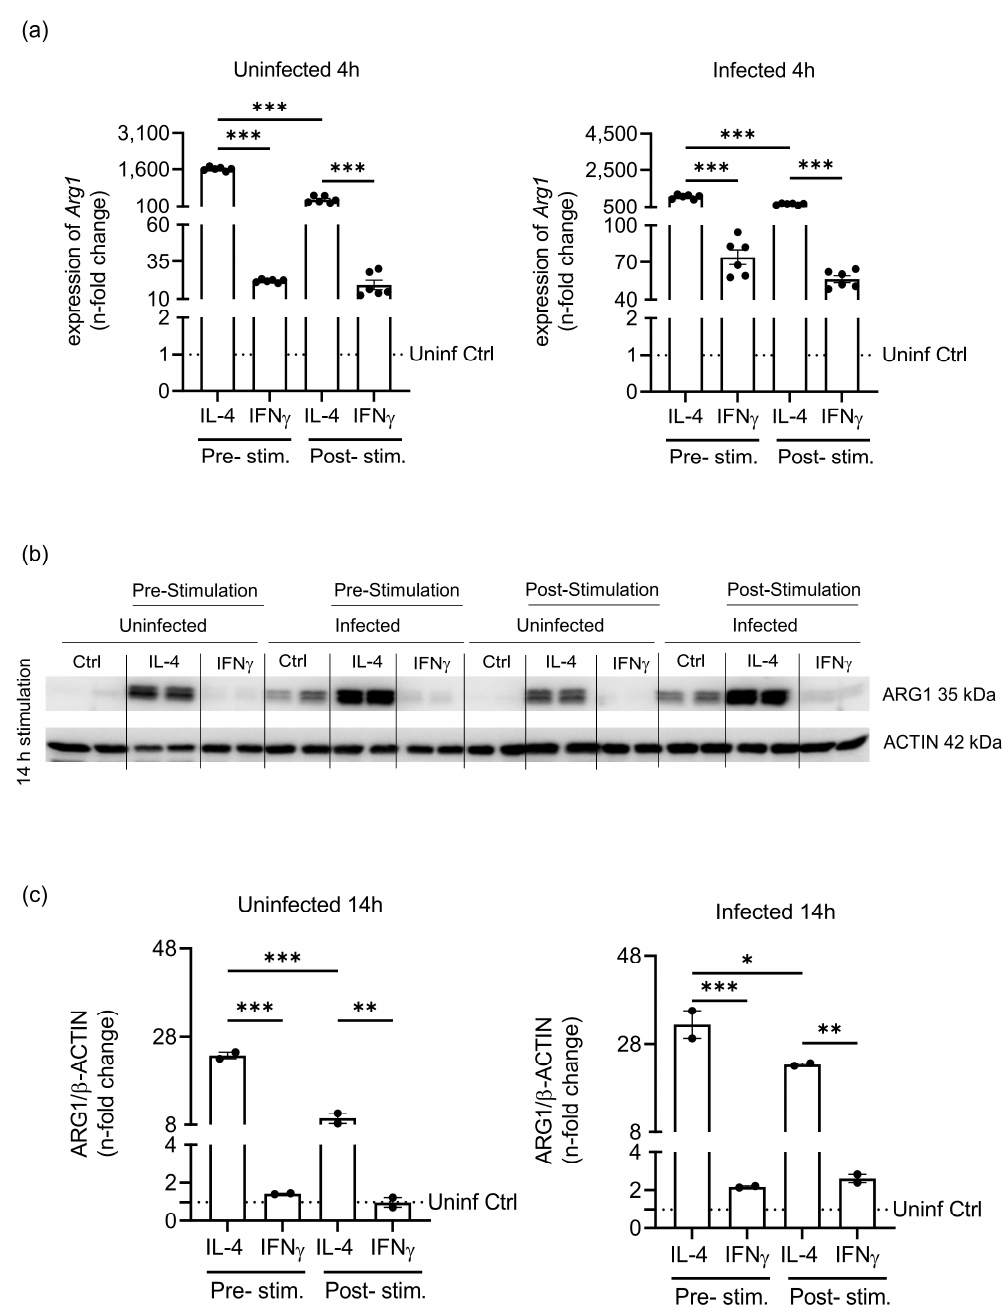
Figure 3. Priming of macrophages before S .tm infection shows differences in ARG1 regulation. Unpolarised BMDM and pre-stimulated polarised BMDM (2 ng/mL IL-4 or 20 ng/mL IFN γ ) were infected with S .tm for 1 h. Unpolarised cells were then stimulated (post-stimulation) with 10 ng/mL IL-4, 100 ng/mL IFN γ or left unstimulated for 4 h or 14 h. ARG1 mRNA and protein levels in pre- and post-stimulation conditions were analysed in uninfected and infected macrophages. ( a ) Arg1 gene expression depending on stimulation (IL-4 or IFN γ ) and infection. Arg1 transcript levels were determined by quantitative real-time PCR and normalized to Hypoxanthine phosphoribosyltransferase ( Hprt ) mRNA levels using the ∆∆ CT method. ( b ) Western blot analysis of ARG1 and β -ACTIN. ( c ) Densidometrical quantification of immunoblotting results relative to β -ACTIN expression. Statistical significance was determined by one-way ANOVA with Tukey post hoc test (a + c). * p -value < 0.05; ** p -value < 0.01; *** p -value < 0.001. Representative data from three independent experiments (mean ± SEM) performed in technical duplicates are shown. Data were normalised to the unstimulated, uninfected